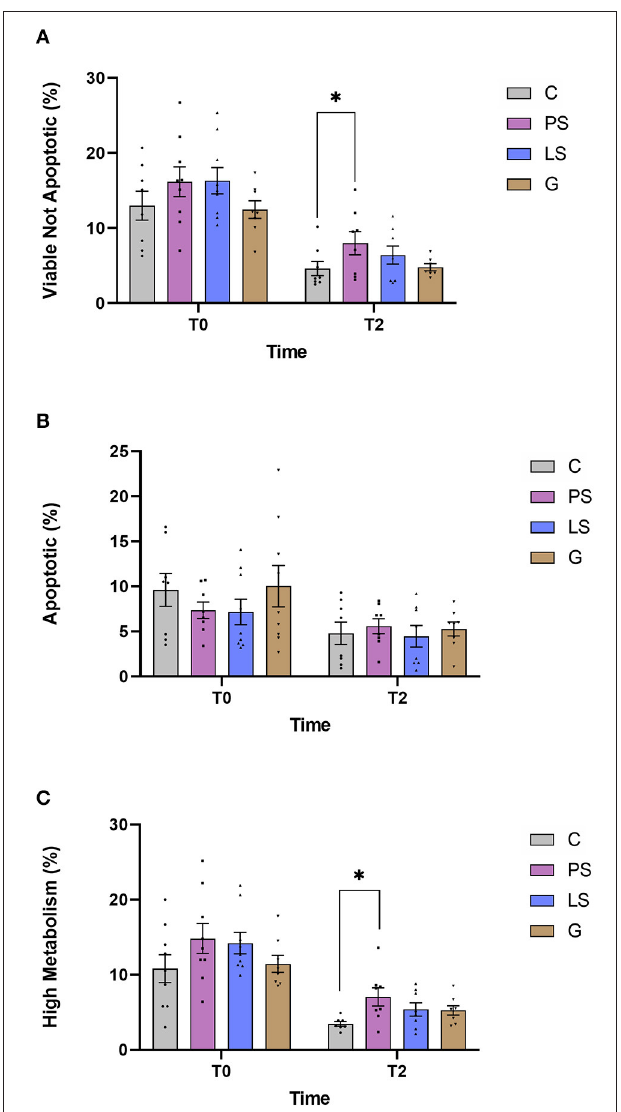
FIGURE 2 | Ram sperm multiparametric flow cytometry data in the four experimental groups by time (just after thawing -T0- and after 2h of incubation at 37 ◦ C -T2-): Control (C), without antibiotics; Penicillin-Streptomycin (PS); (500 UI) − 625 µ g/mL, respectively; Lincomycin-Spectinomycin (LS); 300–600 µ g/mL, respectively; and Gentamicin (G) 1,000 µ g/mL. (A) Zombie low intensity cells and Caspase 3&7 negative cells (viable not apoptotic sperm, %); (B) Zombie low intensity cells and Caspase 3/7 positive cells (apoptosis, %); (C) Zombie low intensity cells and CellROX-positive cells (Sperm with high metabolic activity, %). Nine males were analyzed (1 ejaculate per male) including the same males in each experimental group. Graph dots represent individual male ejaculate. Significant differences ( P < 0.05) are represented with an asterisk between the antibiotic treatment and the Control sample without antibiotics.